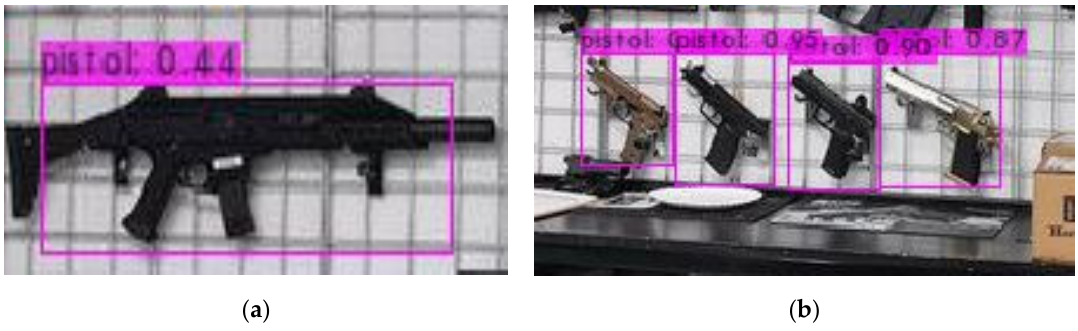
Figure 16. Detection Results of Scaled-YOLOv4 with no background. ( a ) Image with a rifle as weapon hanging horizontally on wall. ( b ) Image with multiple pistols hanging diagonally on the wall.